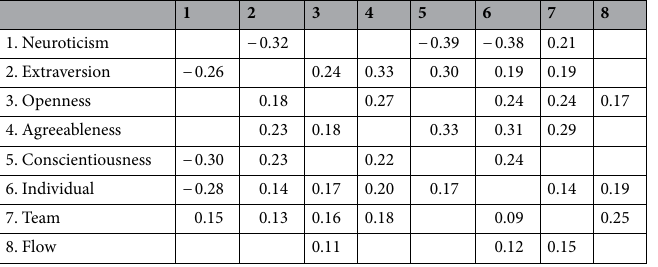
Table 3. Correlations between personality traits and decision-making styles. Above the diagonal are disattenuated correlations, controlled for unreliability (Cronbach’s α). All correlations above 0.15 are significant on the p < 0.01